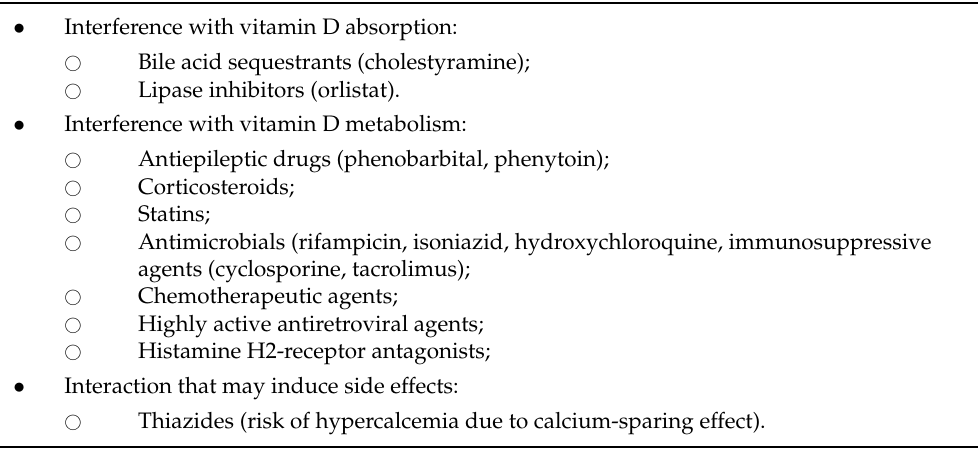
Table 3. Drug interactions with vitamin D/hormone